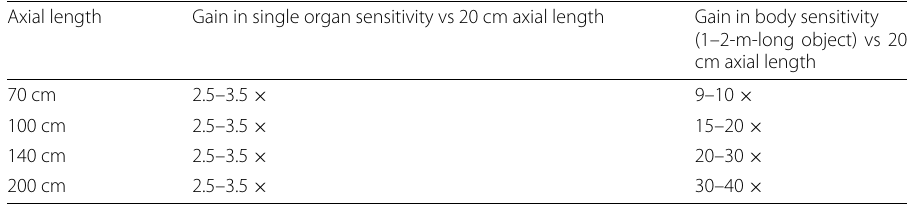
Table 3 Gain for different objects and axial length of total body PET systems Axial